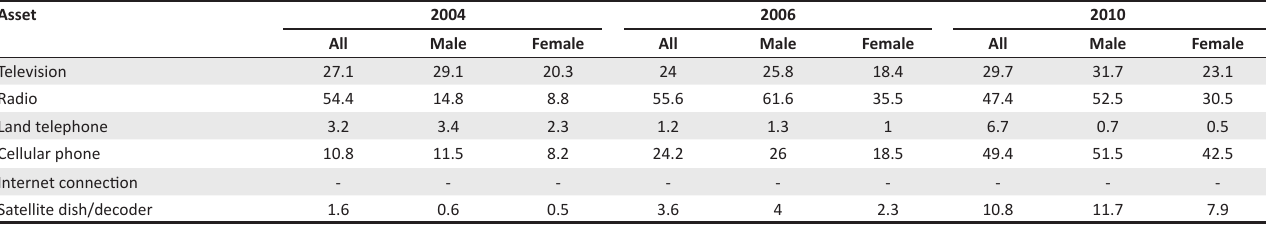
TABLE 6: Ownership of Information and Communication Technologies assets by